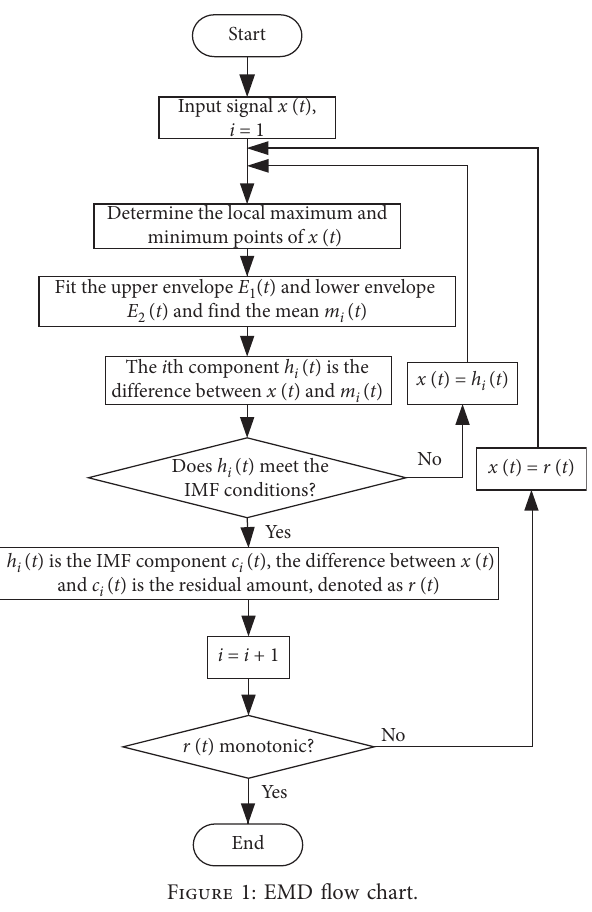
Figure 1: EMD flow